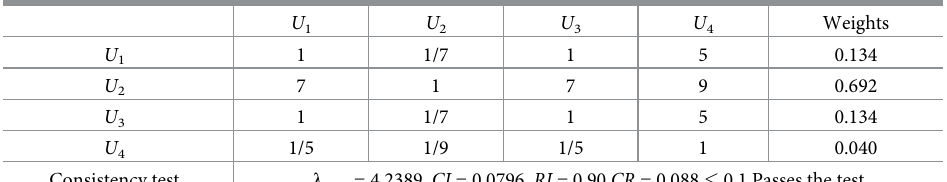
Table 7. Completion performance of quantitative